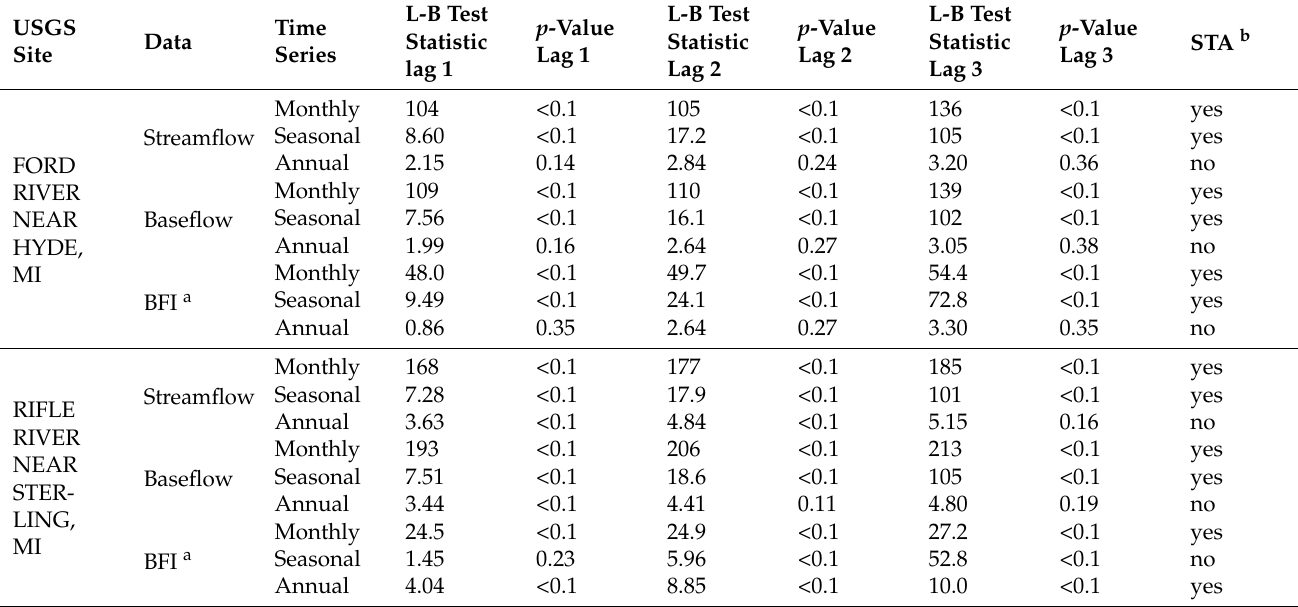
Table 3. Ljung–Box (L-B) test results for 1956–2019 time